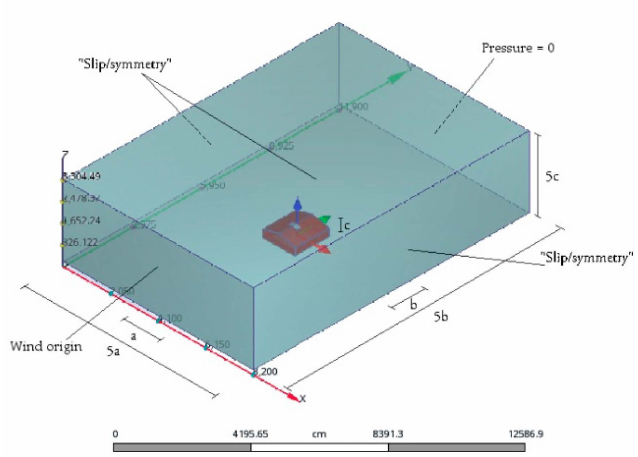
Figure 6. Screenshot in which boundary conditions are indicated (Autodesk CFD ® ).